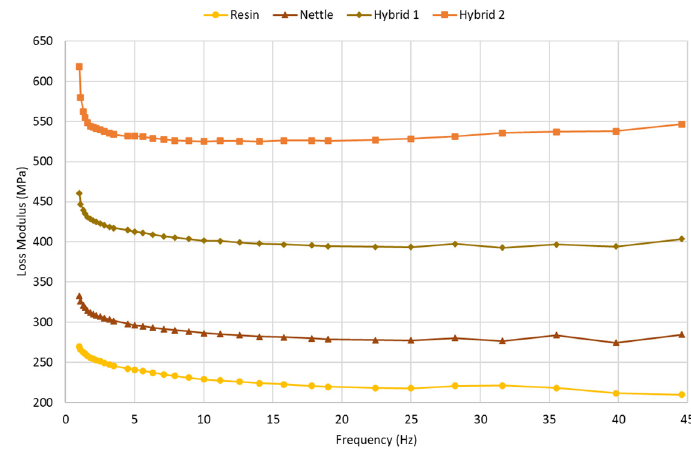
Figure 7. Variation of loss modulus with frequency.